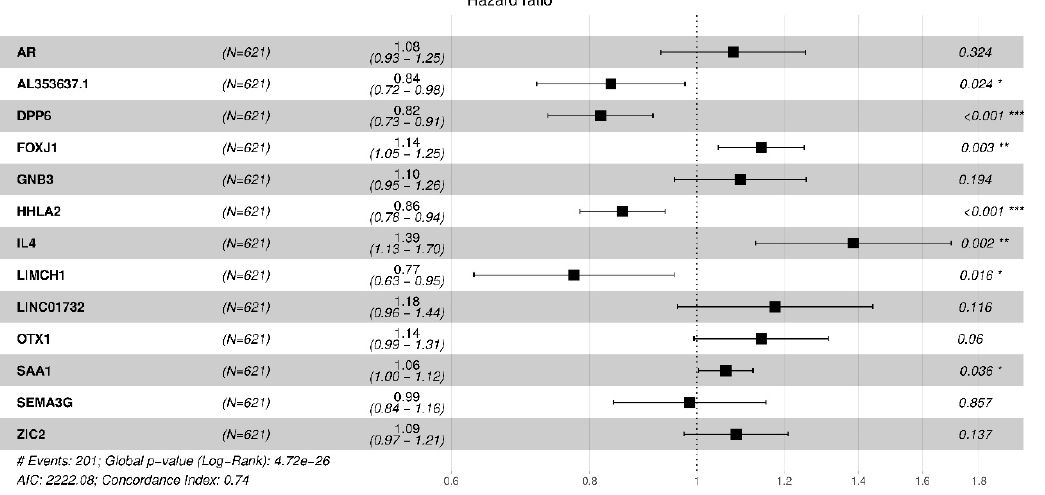
Figure A8. Forest plot for Cox proportional hazards model displaying the significative genes (AL353637.1, DPP6, FOXJ1, HHLA2, and SAA1). The statistical significance between comparisons is given by * p -value < 0.05, ** p -value < 0.01, and *** p -value <